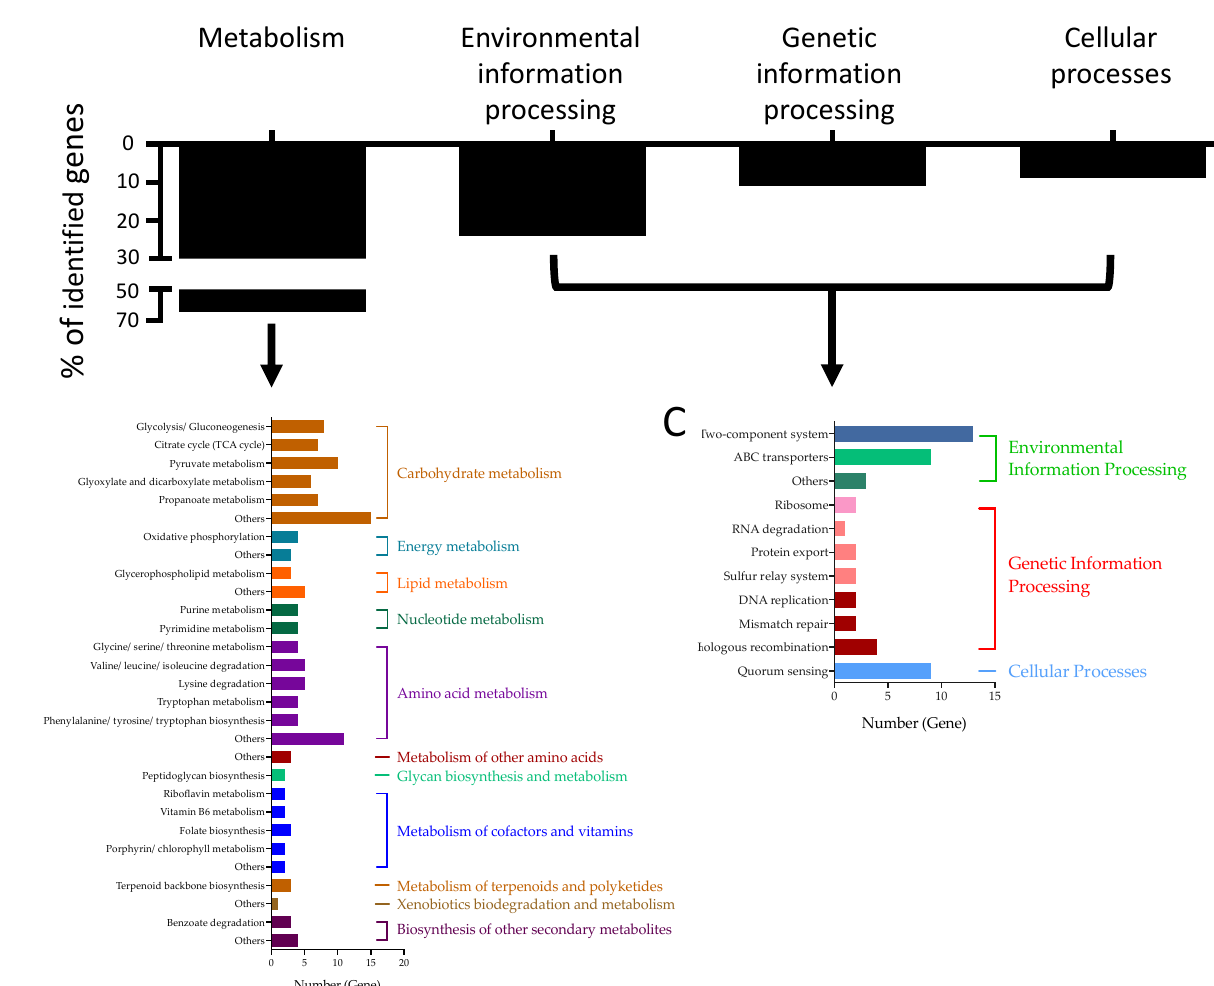
Figure 2. Kyoto Encyclopedia of Genes and Genomes (KEGG) enrichment analysis of the mutant strains significantly decreasing HMEC-1 damage rate: ( A ) genes were identified in the KEGG database and belonged to four major KEGG pathways; ( B ) the sub-pathway enrichment analysis of the genes in the metabolism pathway; and ( C ) the sub-pathway enrichment analysis of the genes in the other three pathways.